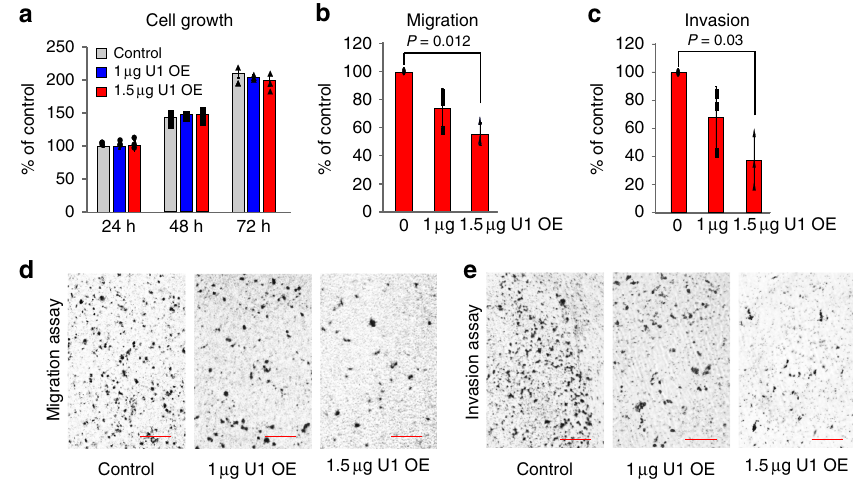
Fig. 2 U1 over-expression decreases cell migration and invasion of HeLa cells in vitro. HeLa cells were transfected with control empty vector or U1 expression plasmids. a Cell growth determined in 24 h intervals. The data are represented as mean ± SD ( n = 3, independent cell culture). b , c Cell migration and invasion were measured 24 h after transfection. The bars indicate mean ± SD ( n = 3, independent cell culture). P -value was calculated with two-tailed Student ’ s t -test. d , e Cell migration and invasion were determined 24 h post-transfection and imaged by phase-contrast microscopy (10x magni fi cation). Scale bar = 250 µ m. Source data are provided as a Source Data fi